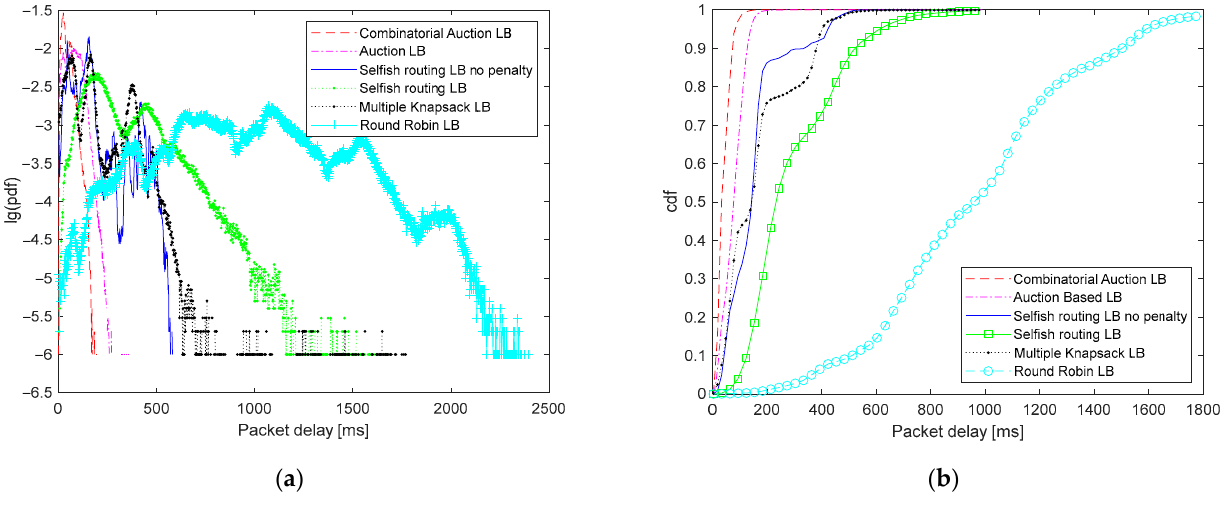
Figure 10. Statistical characterization of the packet delays inserted by the considered LB algorithms: ( a ) The pdfs of the packet delays; ( b ) The cdfs of the packet delays. As expected, the delays experienced by the transmitted packets are the largest in the case of the Round Robin LB algorithm. This algorithm does not consider the statistics of the data flows and the quality of the transmission links over which the tunnels are instantiated.